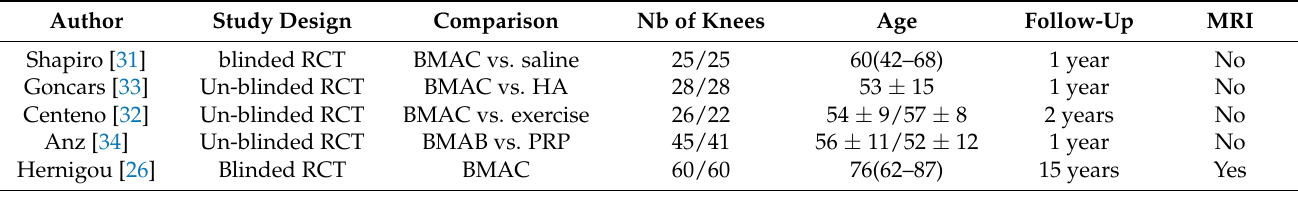
Table 1. Clinical randomized studies with BMAC intra-articular